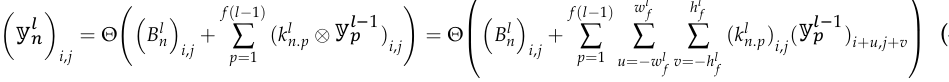
Figure 2. Architecture of the ConvXGB model.